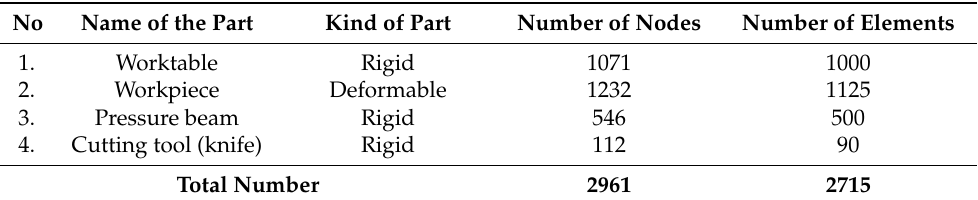
Table 1. Juxtaposition of data concerning the components of a physical